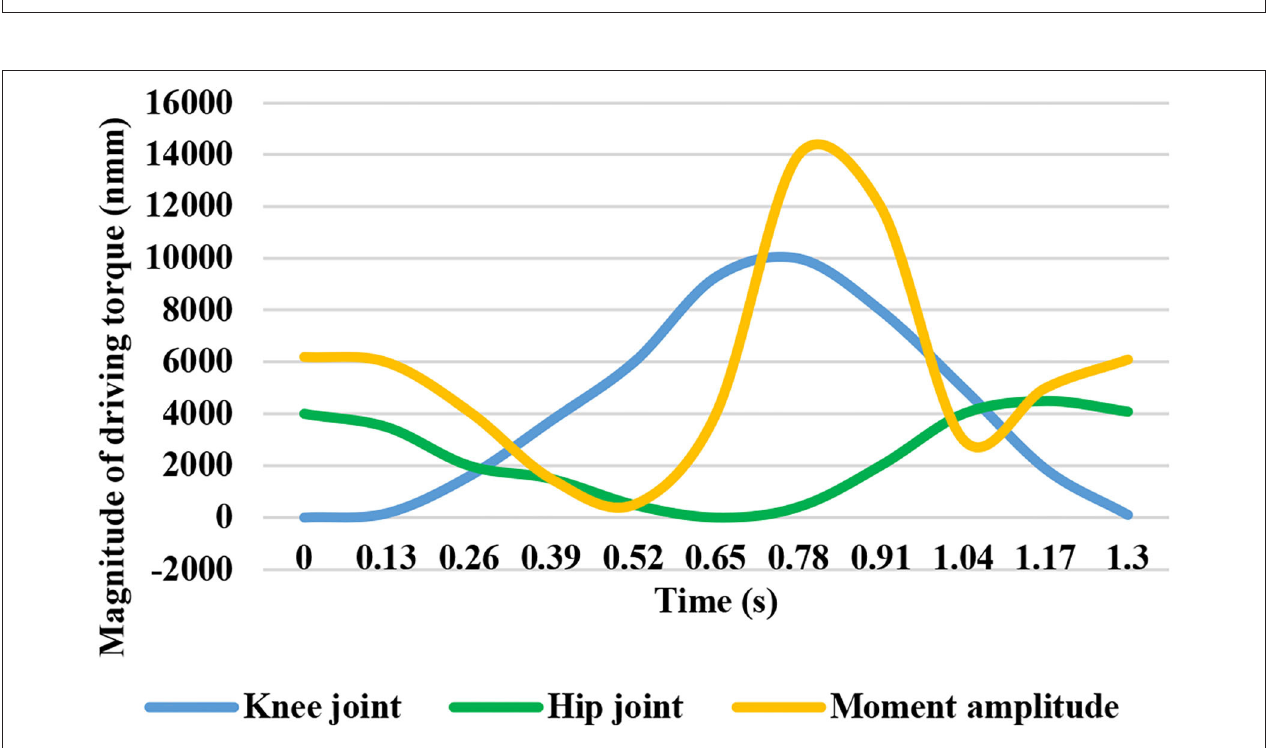
FIGURE 10 | Driving torque amplitude